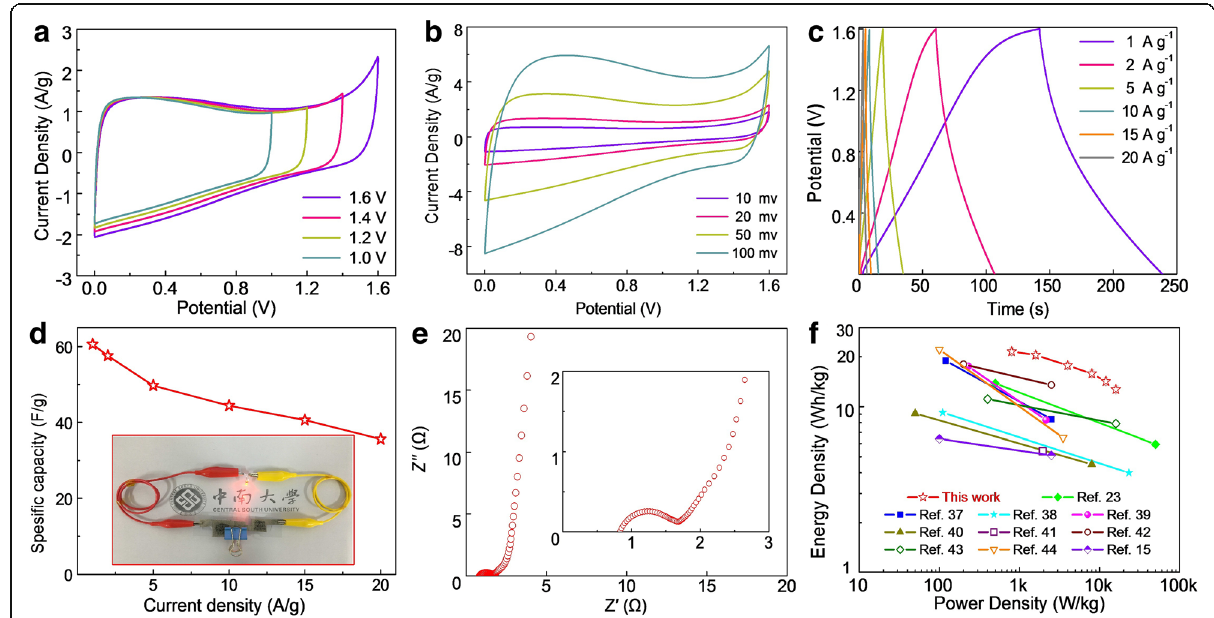
Fig. 6 The electrochemical characteristics of the assembled SSDs based on the NMCSs-600 materials using PVA/KOH as the gel electrolyte in two electrode system. a CV curves of the SSD in different voltage windows from 1 to 1.6 V at the scan rate of 20 mV s − 1 . b CV curves of the SSD at various scan rates within a voltage window of 1.6 V. c GCD curves at different current densities. d The gravimetric capacitance of the SSD as a function of current density, the inset image shows a commercial red LED powered by two SSDs in series. e Nyquist plot of the SSD, the inset gives the magnify plot for high frequency range. f Ragone plots of the SSD and the other carbon spheres based symmetric